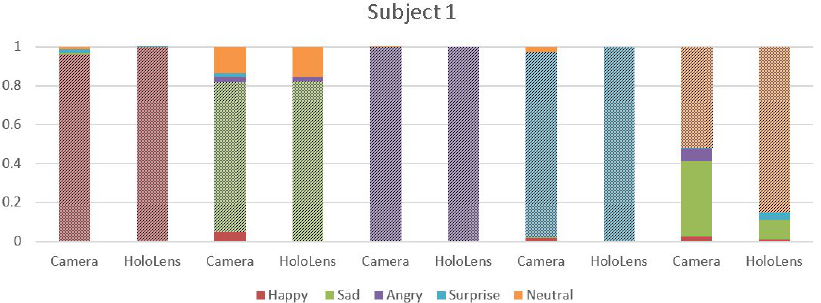
Figure 4. Comparison of average emotion recognition accuracy for the five emotions for Subject 1 using MHL and